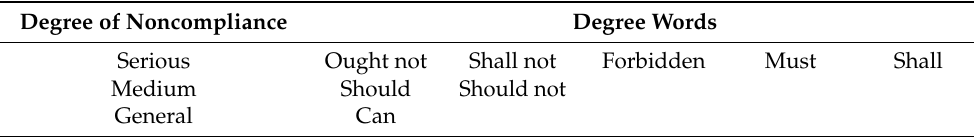
Table 4. Relationship between degree words and noncompliance degrees.